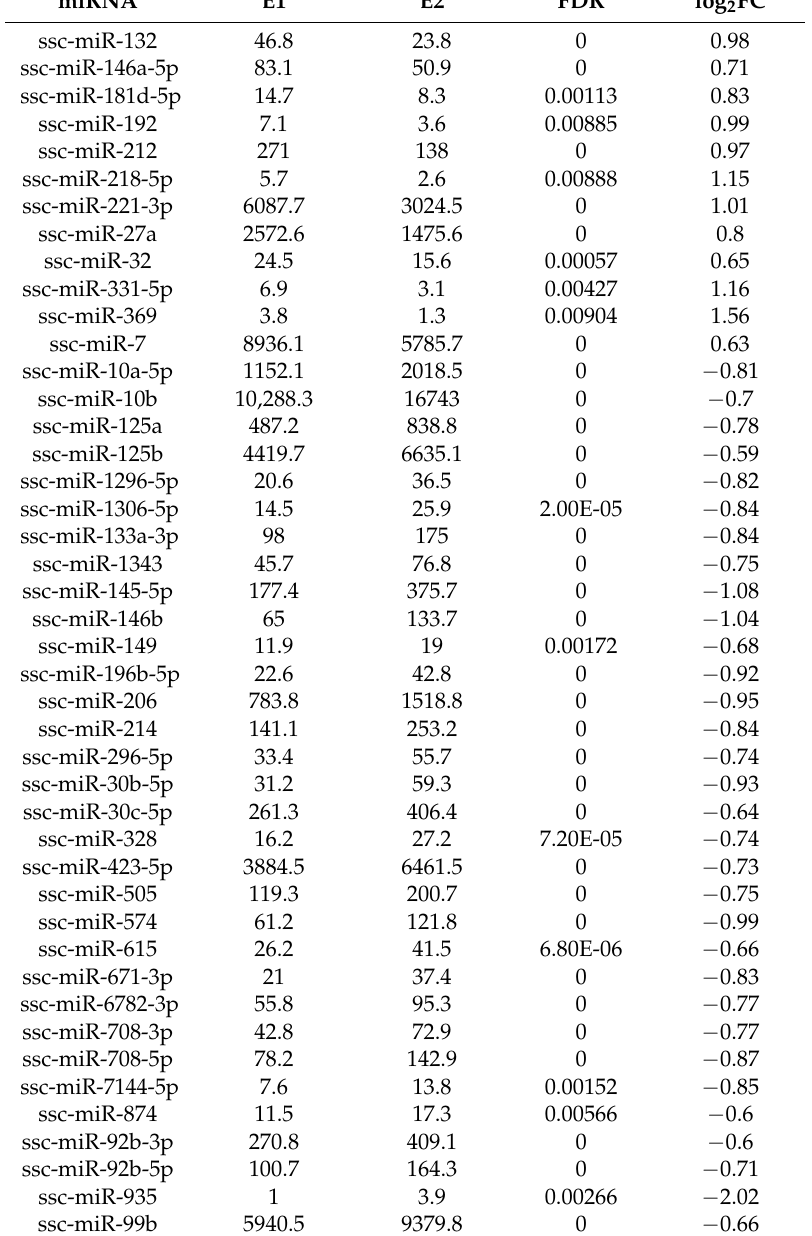
Table 5. Differential miRNA screening in P-N1ICD vs.